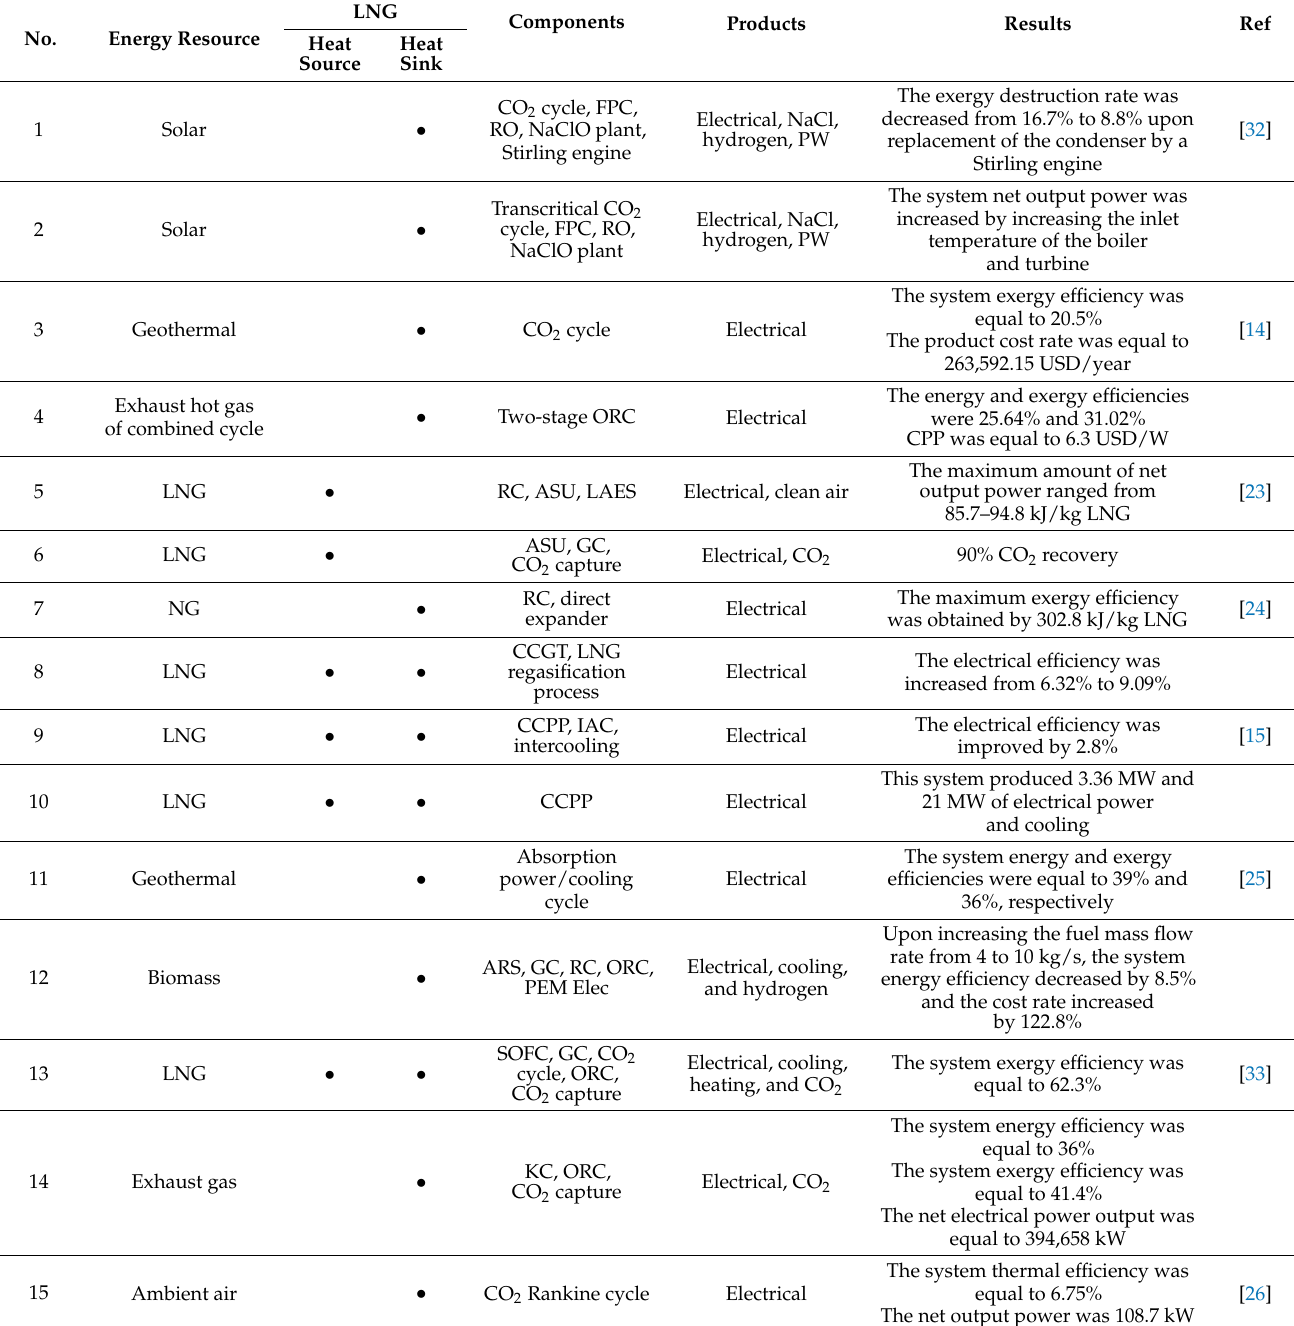
Table 1. Studies related to multigeneration